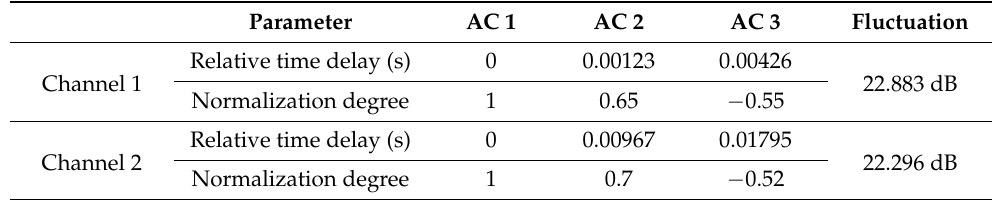
Table 2. Acoustic parameters of the channel.